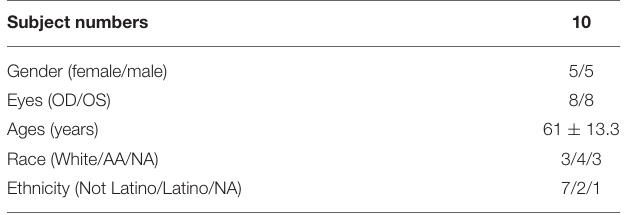
TABLE 1 | Demographic information of subjects.